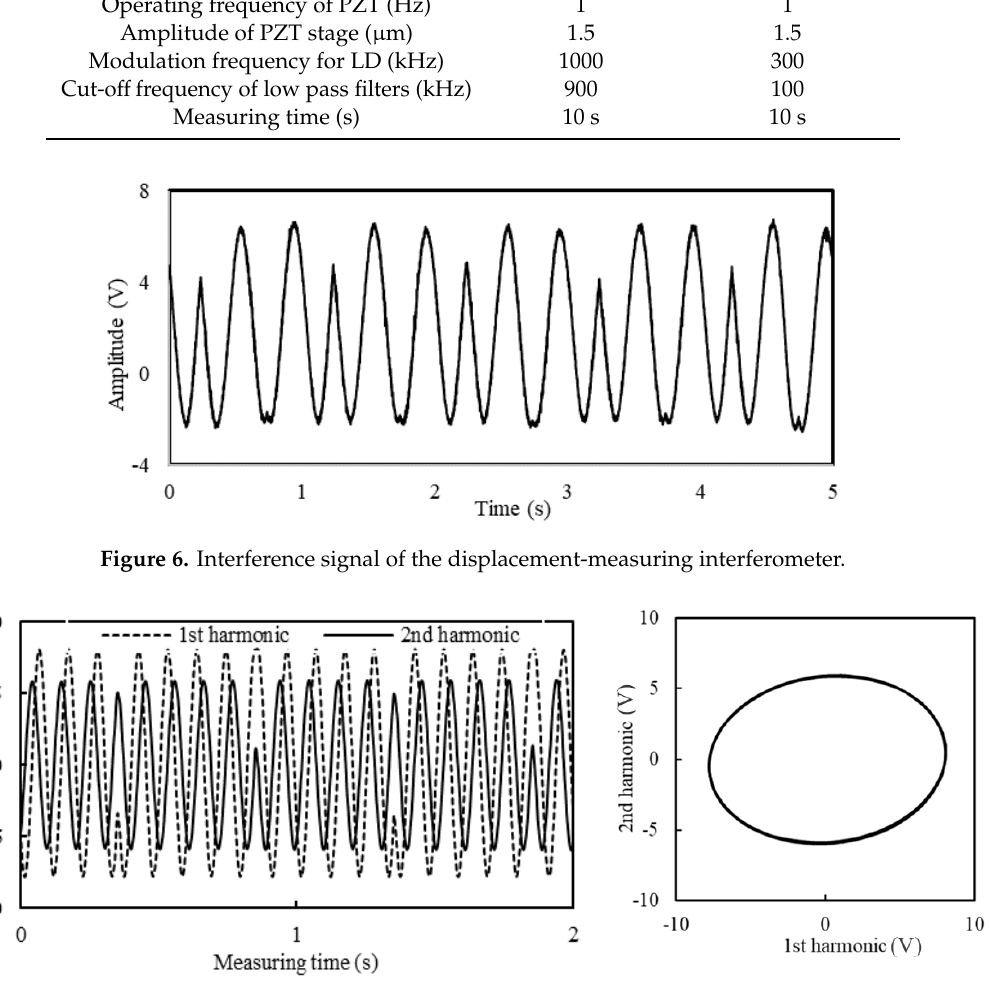
( b ) Figure 8. Displacement-measuring result: ( a ) the displacement-measuring result using the interferometer (black line) and the capacitive sensor (red line); ( b ) the displacement difference between the interferometer and the capacitive sensor. Figure 9. The difference in the displacement measuring result between the new system and our previous one. In order to verify the performance of the interferometer at a higher measurement speed, the interferometer was employed to measure the axial error of a spindle. The spindle (Chuo Precision Industry Co., Tokyo, Japan.) was driven at a velocity of 500 rpm. The axial error of the spindle was measured using the first and second harmonics. An axial error of about 1.3 μ m was measured, as shown in Figure 10. The interferometer could operate stably, even though vibration and air disturbance were present.